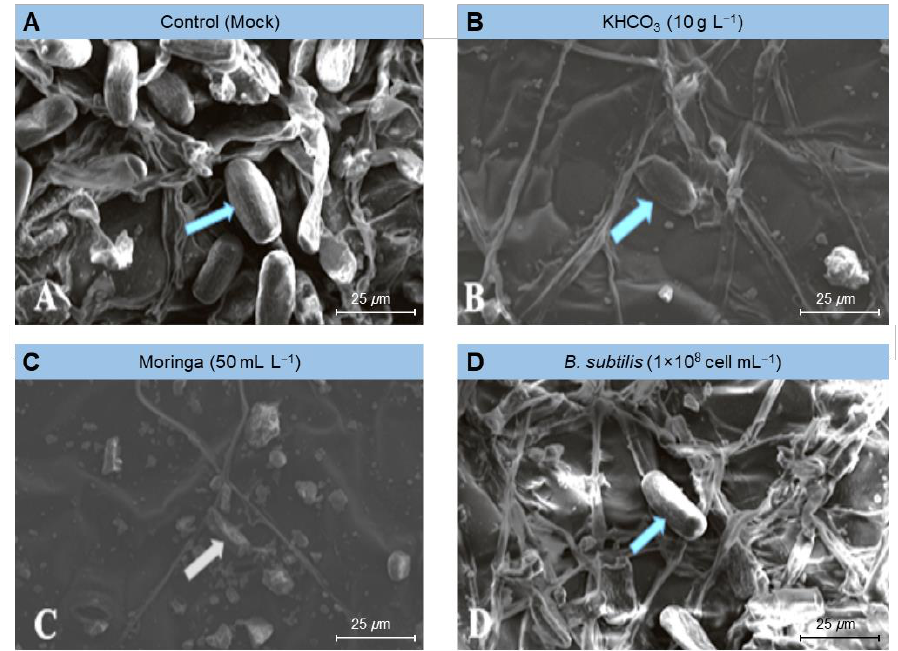
Figure 6. Effect of the most promising treatments on the decomposition of mycelium and conidia of Erysiphe betae , the causal agent of powdery mildew on sugar beet using scanning electron microscopy (SEM). ( A ) mock-treated plants (tap water), ( B ) plants treated with 10 g L − 1 potassium bicarbonate, ( C ) plants treated with 50 mL L − 1 Moringa seeds extract, and ( D ) plants treated with a cell suspension of Bacillus subtilis (1 × 10 8 cell mL − 1